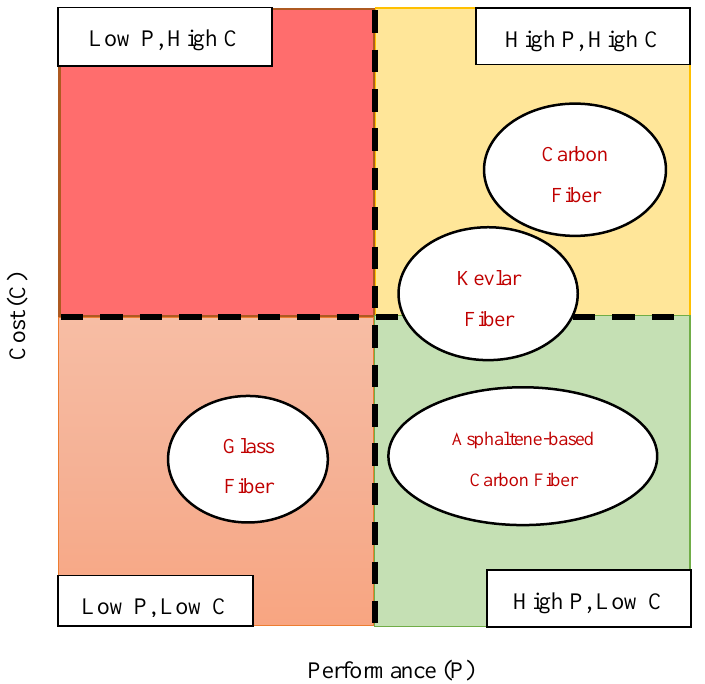
Figure 24. The cost/performance assessment for reinforcing fibers using a market potential diagram.